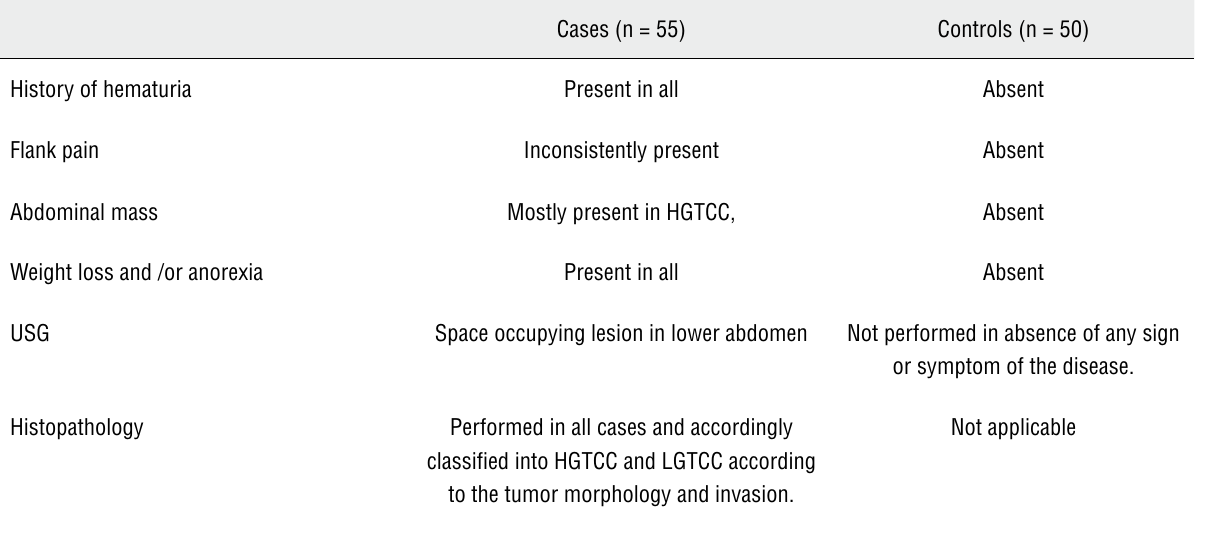
Table 1 - Criteria for selection of cases and